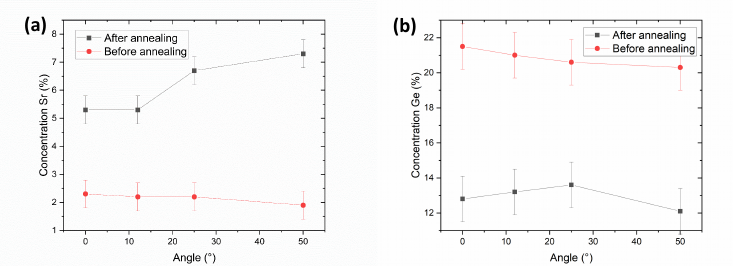
Figure 4. Angle-dependent XPS-determined elemental concentrations of the x = 2.5% samples before and after annealing. The Sr and Ge concentrations are shown in ( a , b ) respectively. The angle is defined with respect to the surface normal of the samples.